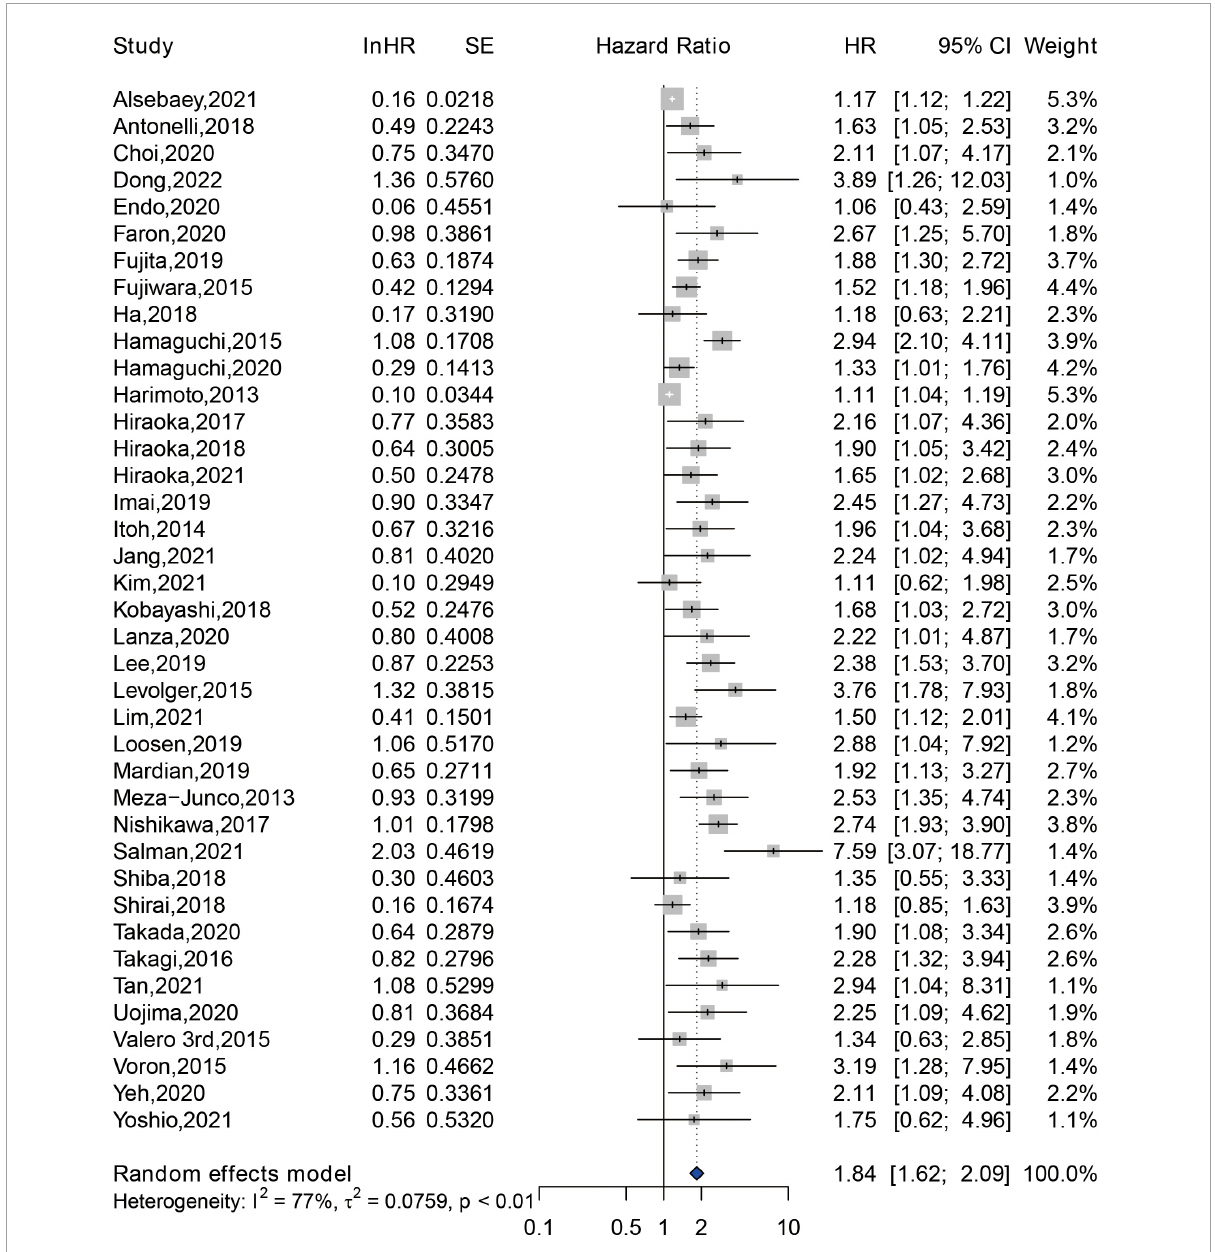
FIGURE3 Forest plot of the pooled hazard ratio for association between sarcopenia and overall survival in patients with hepatocellular